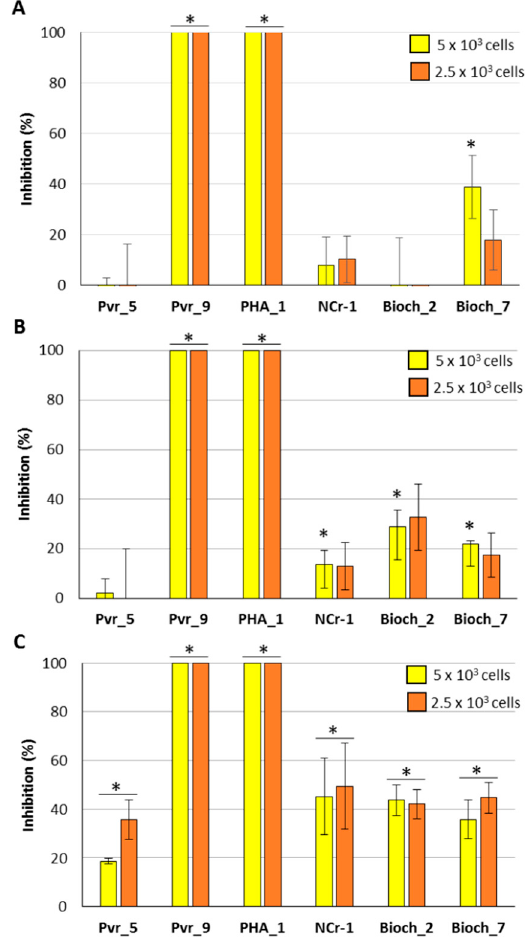
Figure 2. Antifungal activity of bacteria co-inoculum against A. flavus ( A ), F. verticillioides ( B ), and F. proliferatum ( C ) . Concentrations of 5 or 2.5 × 10 3 bacterial cells were co-inoculated with 5 × 10 3 of fungal conidia. Data are presented as percentage inhibition with respect to the control (only fungal cultures) and are the means of six biological replicates ± standard deviation (S.D.). Asterisks indicate statistically significant differences between control and co-inoculated cultures according to ANOVA and Tukey’s test ( p < 0.05).